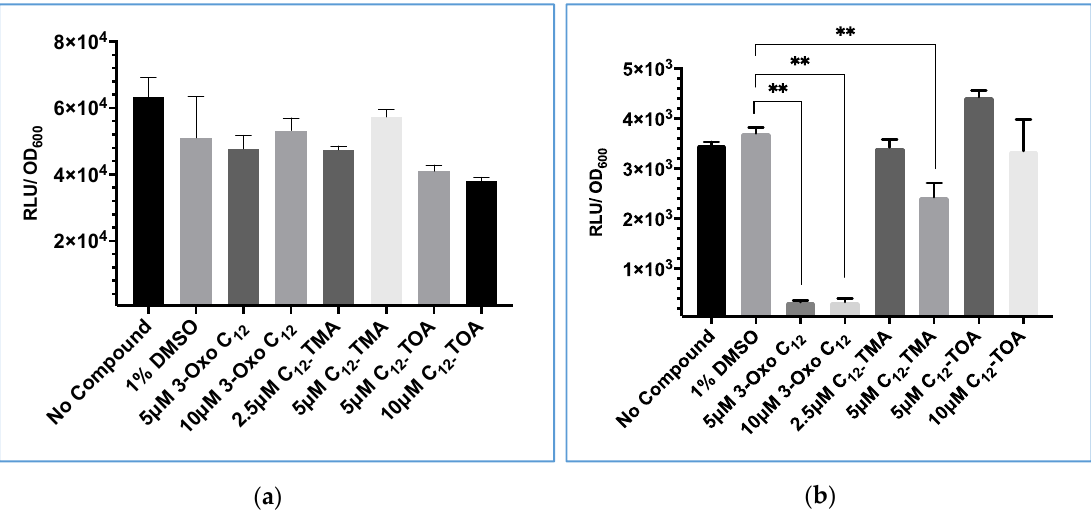
Figure 6. Comparison of the e ff ect of 3-oxo-C 12 -HSL, C 12 -TMA and C 12 -TOA on S. aureus constitutively expressing bioluminescence based on ( a ) GLuc or ( b ) Lux. The data shown are the means with error bars displaying standard deviation of triplicate technical repeats and are representative of biological triplicate repeats. ** p < 0.05.